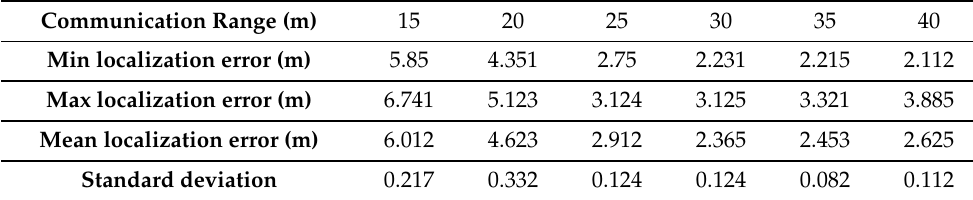
Table 2. Localization error as function of communication